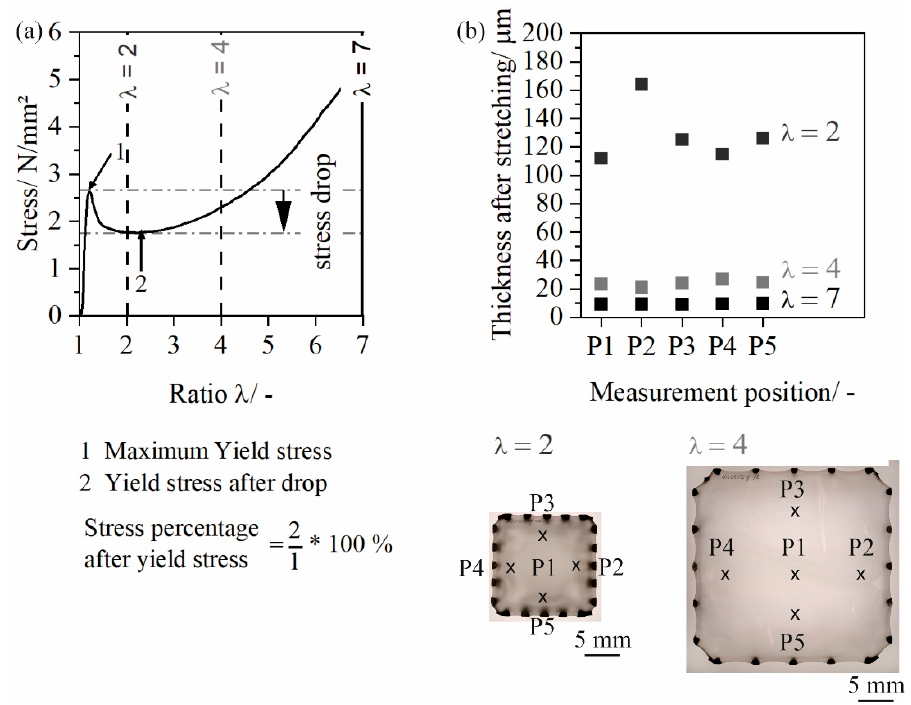
Figure 2. Calculation of the stress percentage after yield stress ( a ); thickness distribution after stretching ( b ).